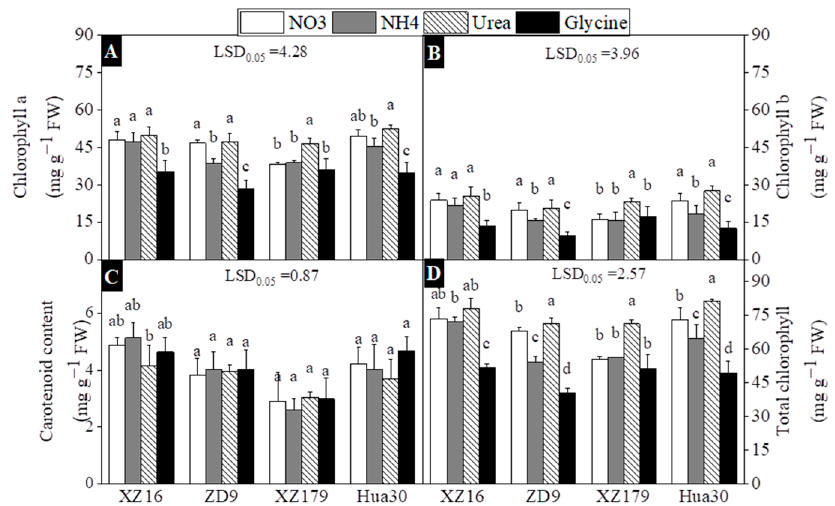
Figure 4. Effects of different nitrogen forms on chlorophyll a ( A ), Chlorophyll b ( B ), carotenoids ( C ), and Total chlorophyll ( D )content of four barley genotypes at 29 day of treatment (stage 4 and day 43 on BBCH scale). All values are expressed as mean ± SD ( n = 4). Significant difference ( p < 0.05) between treatments is indicated by different letters. LSD.05 values in the figures are for the comparison between genotypes.